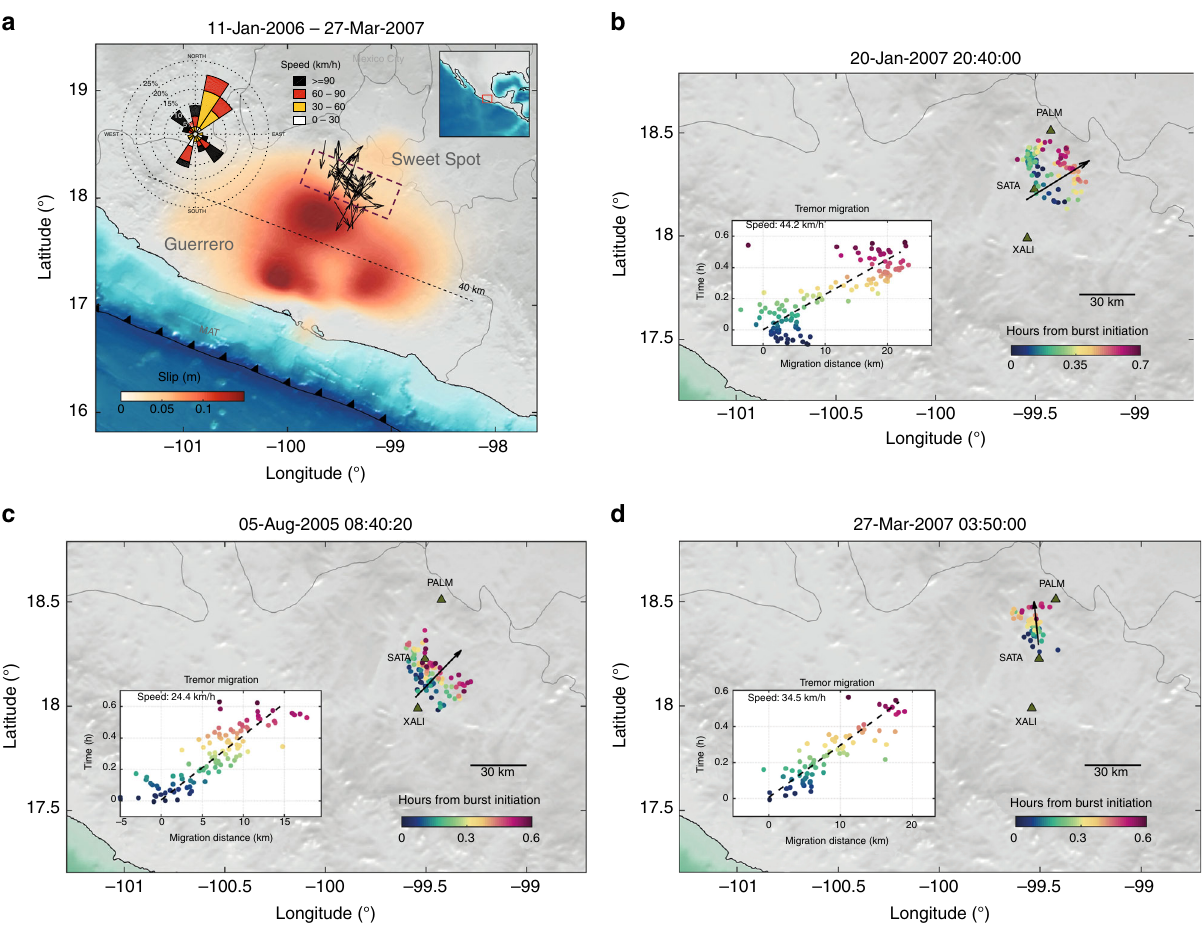
Fig. 3 Rapid tremor migrations observed in Guerrero. a Migration direction and position (black arrows) of the 54 RTMs determined from seismic records in the MASE array of stations 58 using the TREP method 57 . The wind-rose histogram shows the directions and speeds of the whole RTM catalog. As a reference, color shade shows the fi nal slip of the 2006 SSE 55 . The dashed line indicates where the subducted Cocos plate becomes horizontal at 40 km depth, and the wine rectangle the positions of the sweet spot. b – d Examples of RTMs for 1-min moving windows with 20 s overlap. Hypocentral projections onto the migration directions (black arrows) are shown in the insets, where migration speeds are reported (see Supplementary Figure 2 for more RTM examples). The basemaps were created using SRTM15 +